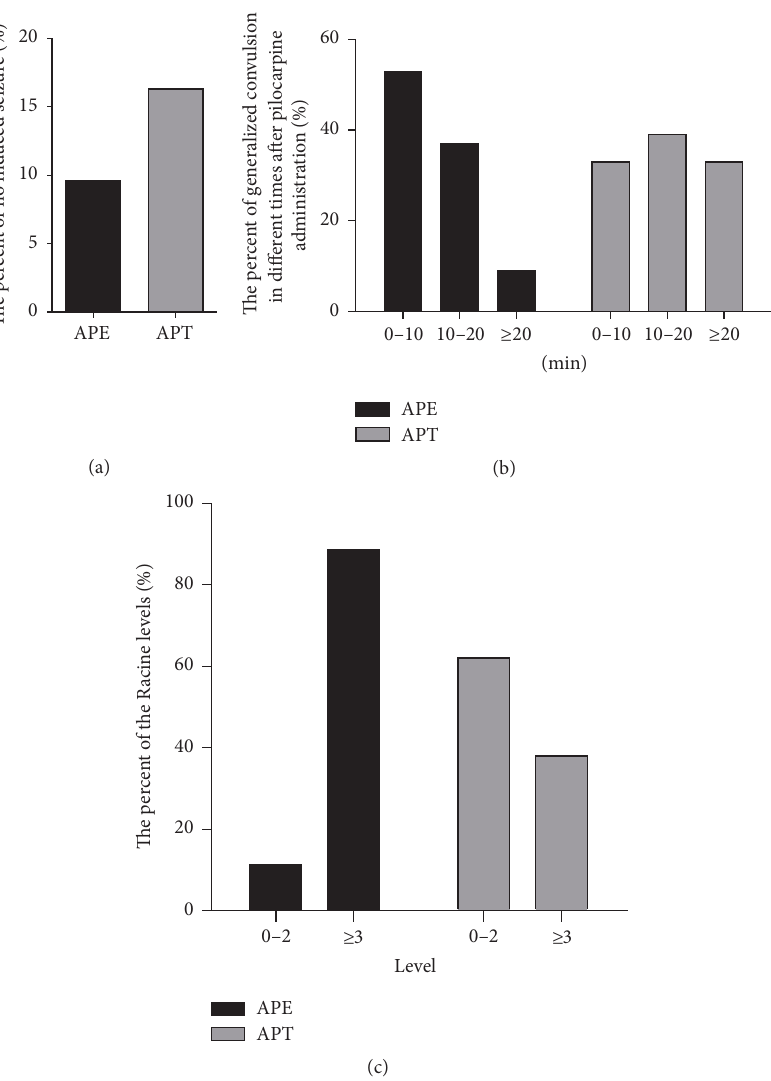
Figure 2: Behavioral observations within 2 h of pilocarpine administration. (a) Compared to the APE group, the percent of no induced seizures in the APT group increased by 6.7%; (b) the percentages of generalized convulsions were analyzed at different times after pilocarpine administration (0–10, 10–20, and ≥ 20min) and revealed that the latency to generalized convulsions in the APT group was extended compared to the APE group; (c) the percentages of Racine levels (0–2 and ≥ 3) were analyzed based on the Racine scale and revealed that seizure severity in the APT group was reduced compared to the APE